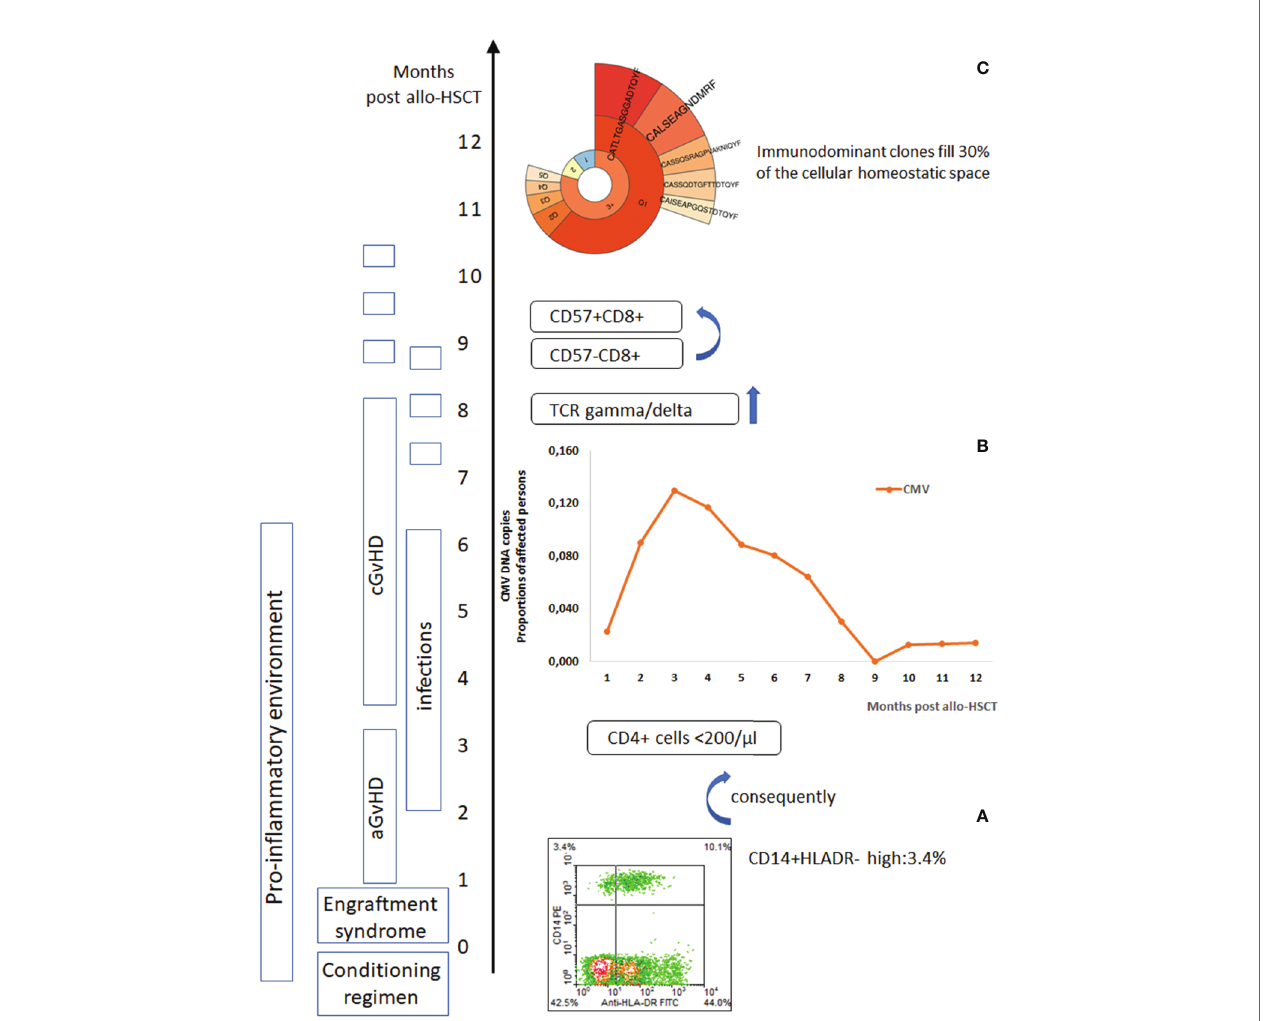
FIGURE 1 | Post-alloHSCT chain of events affecting immune system competence. (A) Post-alloHSCT toxicity induces a pro-in fl ammatory environment with an increase in blood monocytic-marrow derived suppressor cells (CD14+HLADR-) (8), (B) Herpes viruses reactivate (CMV reactivation events in post-transplant period) (28, 29), in the peripheral blood lymphocytes CD8+CD57+ cells increase (110) – T cell repertoire skewed to highly differentiated T cells effective against chronic infection epitopes but neglecting new challenges, (C) TCR gamma/delta cells reprogrammed by CMV reactivation appear frequently in the blood (prevalence of deltaV2 negative cells) (111), immunodominant clones expand